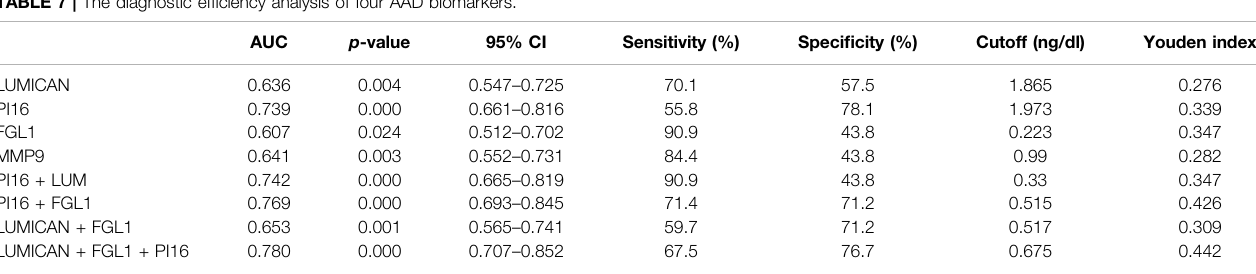
TABLE 7 | The diagnostic ef fi ciency analysis of four AAD biomarkers. AUC p -value 95% CI Sensitivity (%) Speci fi city (%) Cutoff (ng/dl) Youden